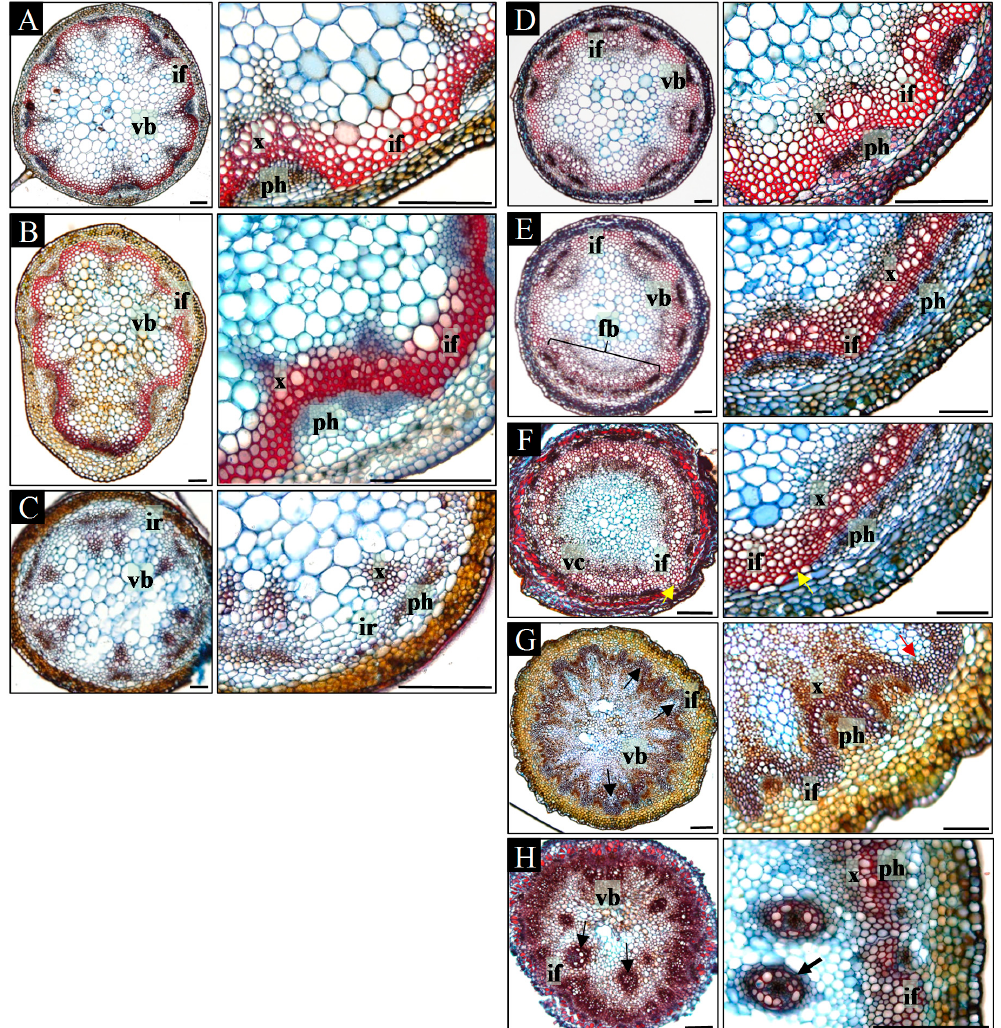
Figure 2. Ontogenetic changes in the structure of the inflorescence shoots. Subsequent cross-sections of the inflorescence shoot of WT ( A – C ) and pin1 mutant ( D – H ) plants, showed in the basal-apical sequence. The left picture presents the vascular strands arrangement, and the right picture the magnification of the interfascicular region. The stem of the WT plant has in its basal part discrete vascular bundles ( A ); under the first branch increased number of bundles ( B ); and in the apical region the stem lacks differentiated interfascicular fibers ( C ). The stem of the pin1 mutant is characterized by (looking from the most basal part of the stem towards the top) regions with: discrete vascular bundles ( D ); fusing bundles ( E ), denoted with bracket; the vascular cylinder, with interfascicular fibers displaced towards the pith ( F ), direction of fibers displacement denoted with arrow; vascular cylinder splitting into numerous small bundles, with interfascicular fibers displaced towards the stem surface ( G ), direction of fibers displacement denoted with arrows; concentric bundles in the pith of the stem ( H ), denoted with arrows. vb—vascular bundle, fv—fusing vascular bundles, vc—vascular cylinder, if—interfascicular fibers, ir—interfascicular region, x—xylem, ph—phloem. Scale bar 100 μ m.